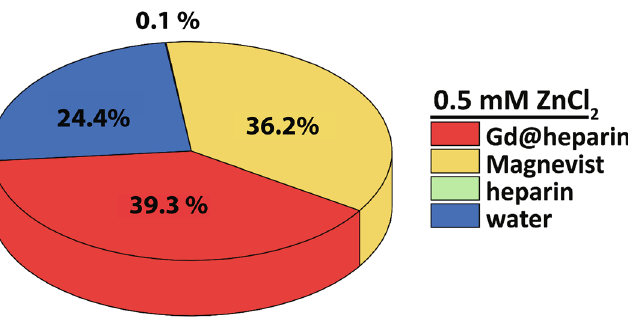
Figure 6. Pie chart of the individual contributions of water (blue; R 1,H R R 1,GBCA ), heparin (green; 1,heparin ), and of formed Gd-heparin complexes (red; observed relaxation rate after a stimulus of 0.5 mM ZnCl 2 at 9.4 T and 25 °C. Although just ~ 15% of the Gd 3+ ions transchelated to heparin (c.f. Fig. 5B), their contribution (39.3%) already exceeds the contribution (36.2%) of the remaining 85% of intact